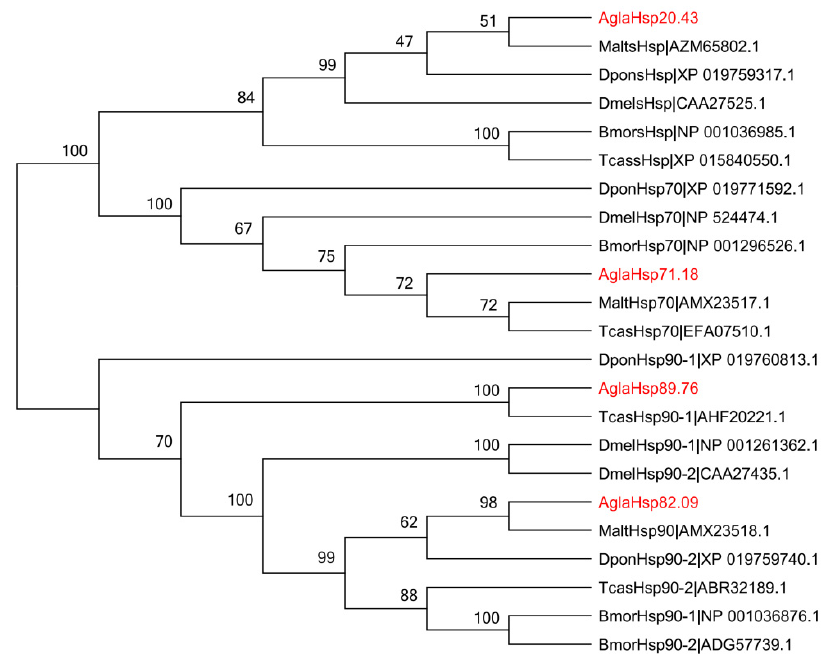
Figure 2. Phylogenetic analysis of Hsps from Anoplophora glabripennis , Tribolium castaneum , Monochamus alternatus , Dendroctonus ponderosae , Drosophila melanogaster , and Bombyx mori . An unrooted phylogenetic tree of Hsps from six insect species was constructed using MEGA6.05 with the Neighbor-Joining method (node support based on 1000 bootstrap replications is shown). The four AglaHsps are indicated in red.